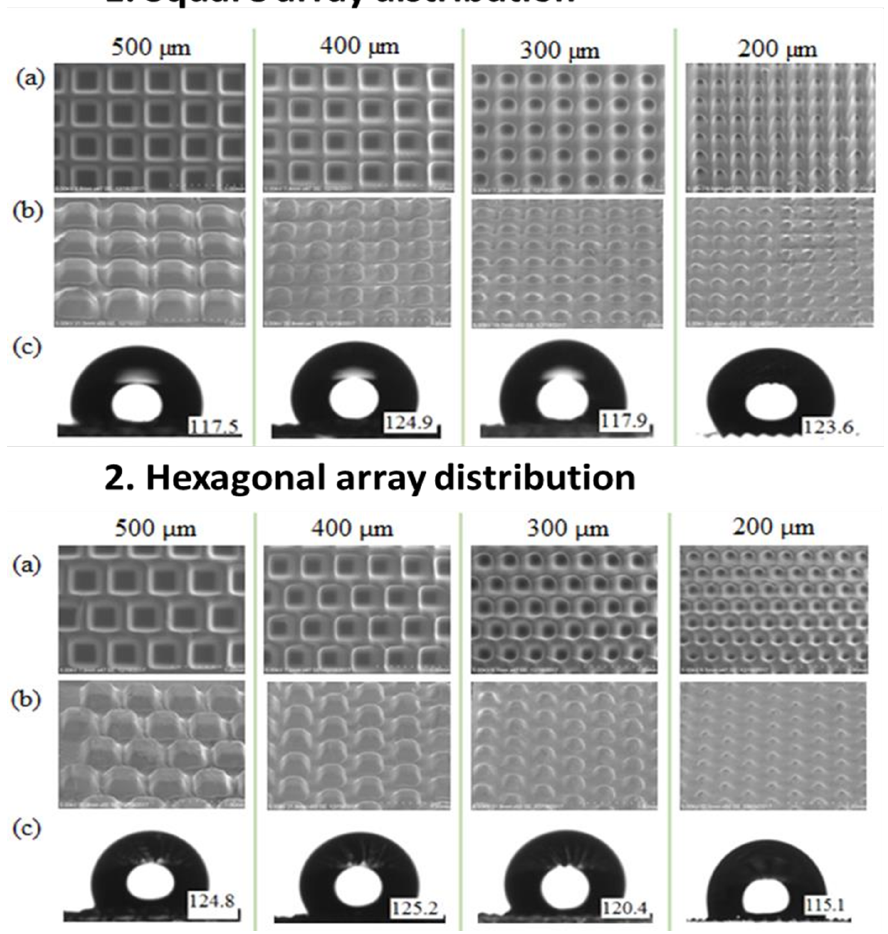
Figure 8. Top view SEM images of: ( a ) SU8 microhole mold, ( b ) replicated PDMS micropillar, and ( c ) water contact angle value for square and hexagonal array